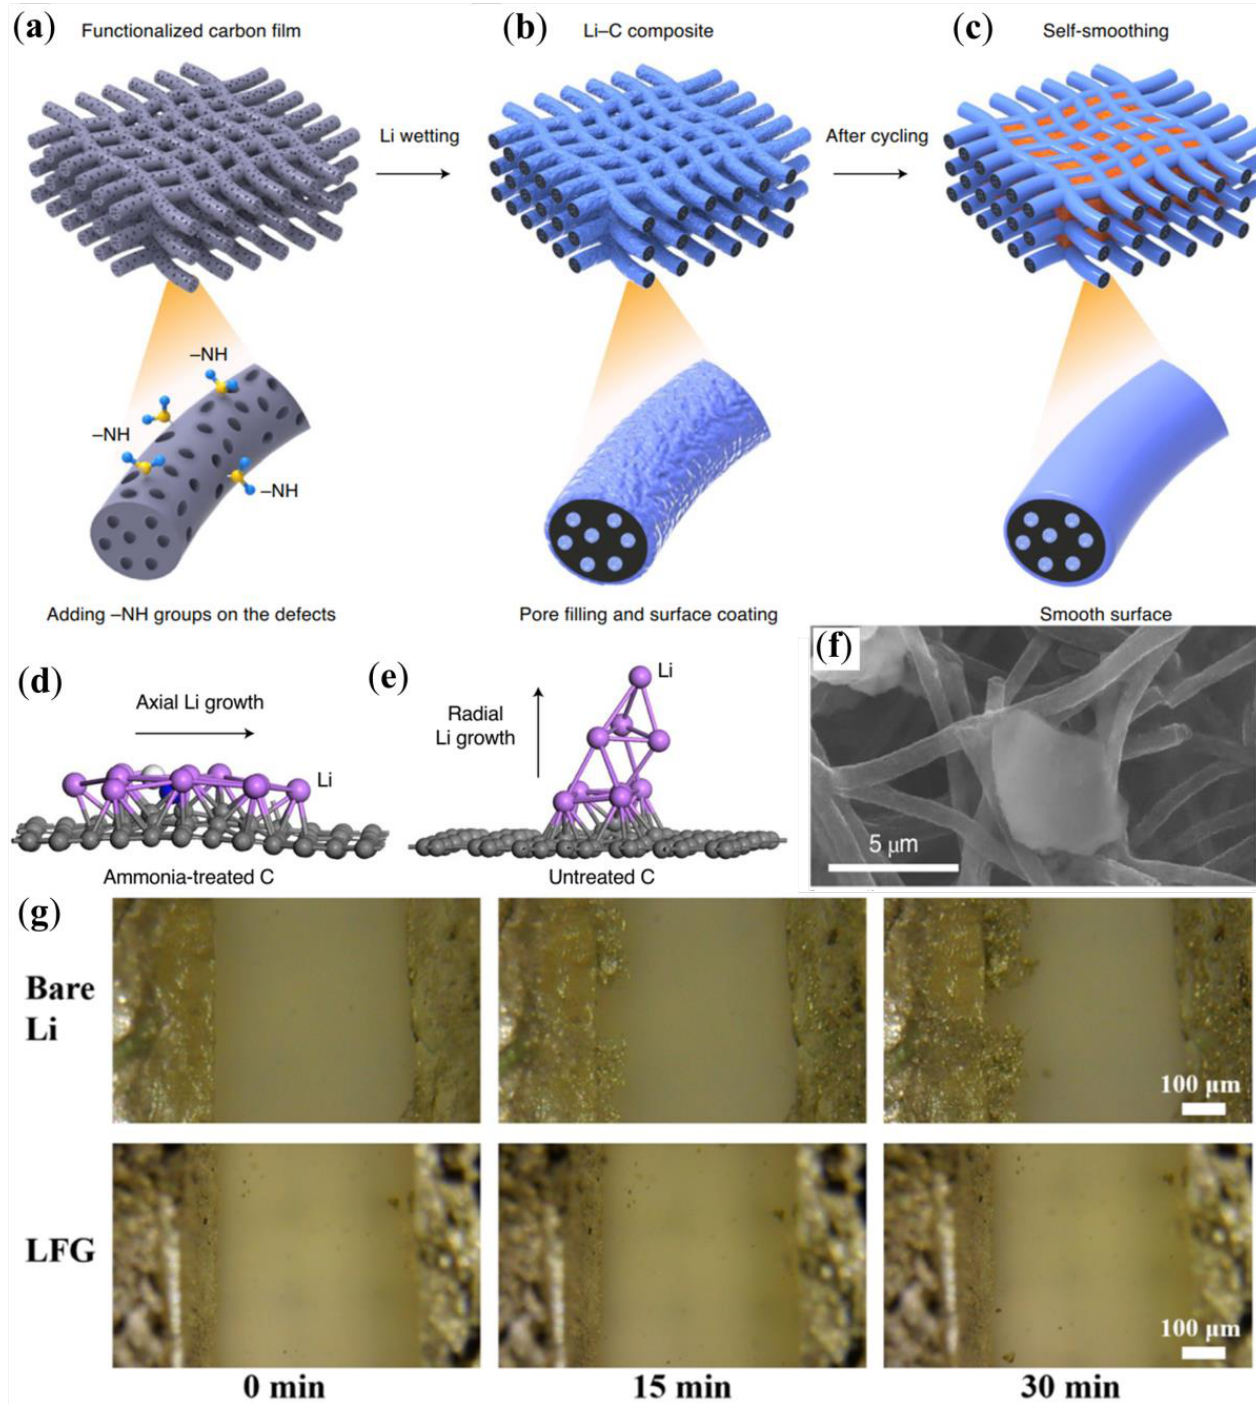
Figure 7. ( a ) –NH functional groups modified the surface of mesoporous CNFs; ( b ) Spontaneous infiltration of Li into CNFs; ( c ) Schematic of rough Li–C surface after electrochemical deposition and stripping process: grey for C; blue for Li; orange for the electrolyte. DFT calculation of lithium growth on ( d ) ammonia-modified, and ( e ) unmodified carbon surfaces: grey for C; blue for N; white for H; purple for Li; ( f ) The SEM image of Li deposition on an untreated carbon film [87]. Copyrights © 2022, Springer Nature. ( g ) After 0, 15, and 30 min, in situ optical images of the plating processes of bare Li and LFG at a current density of 1 mA cm − 2 were taken [88]. Copyrights © 2022 American Chemical